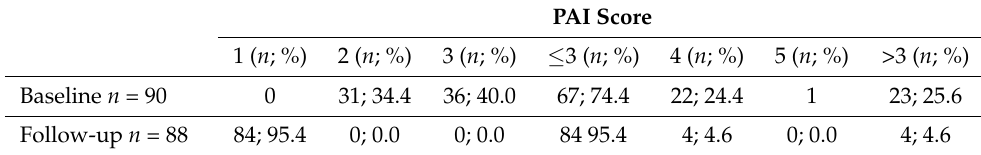
Table 2. PAI score.